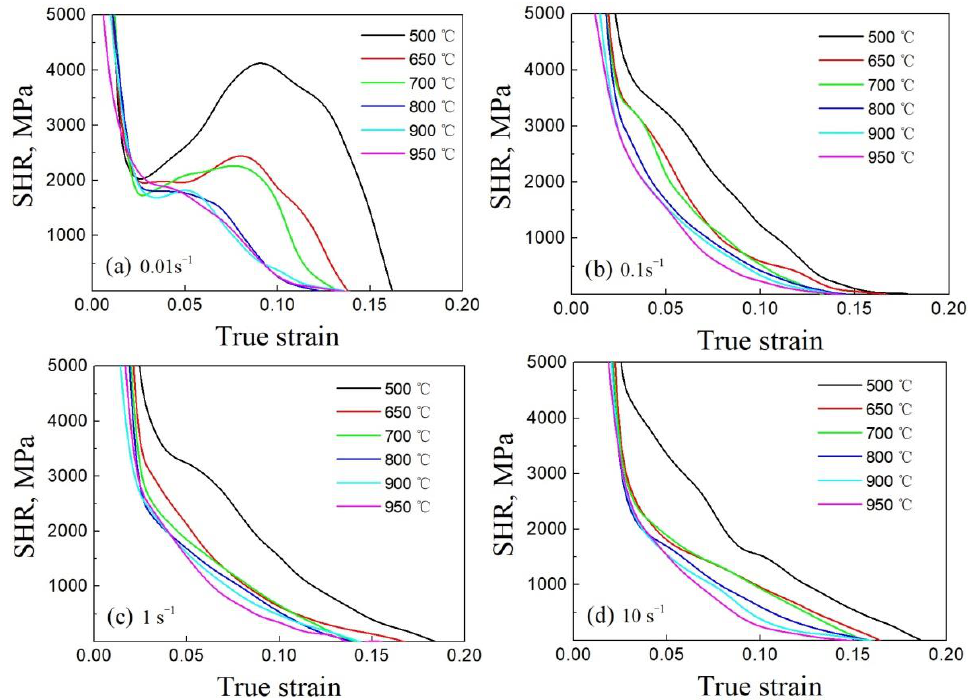
Figure 5. The relationship between SHR and true strain of the studied steel at stain rates of ( a ) 0.01 s −1 , ( b ) 0.1 s −1 , ( c ) 1 s −1 and ( d ) 10 s −1 .